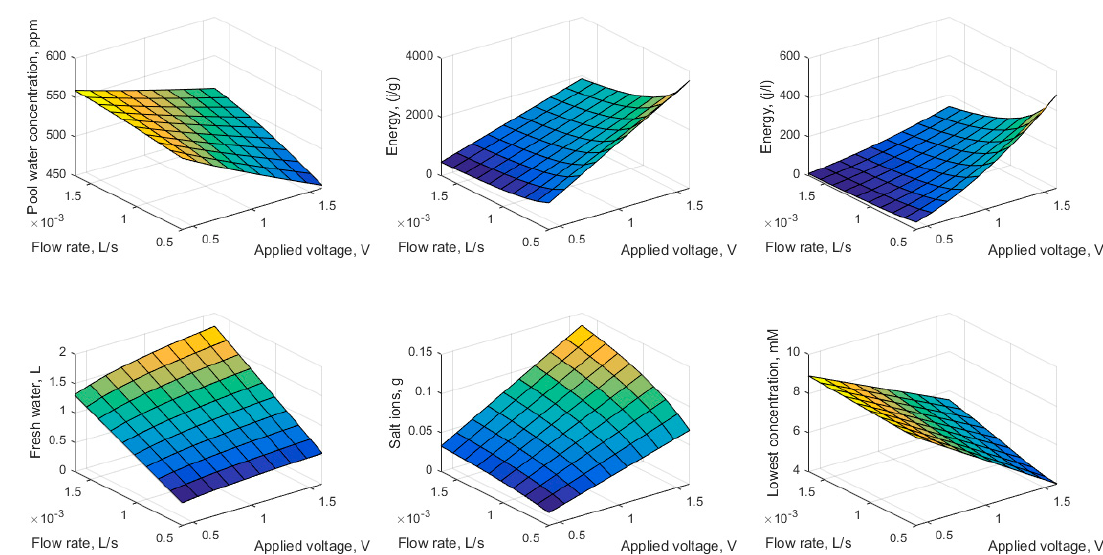
Figure 2. Impact of applied voltage and flow rate upon CDI performance. While other operating parameters are constant; Capacitance: 200 F, Cell volume: 100 mL, feed concentration: 10 mM